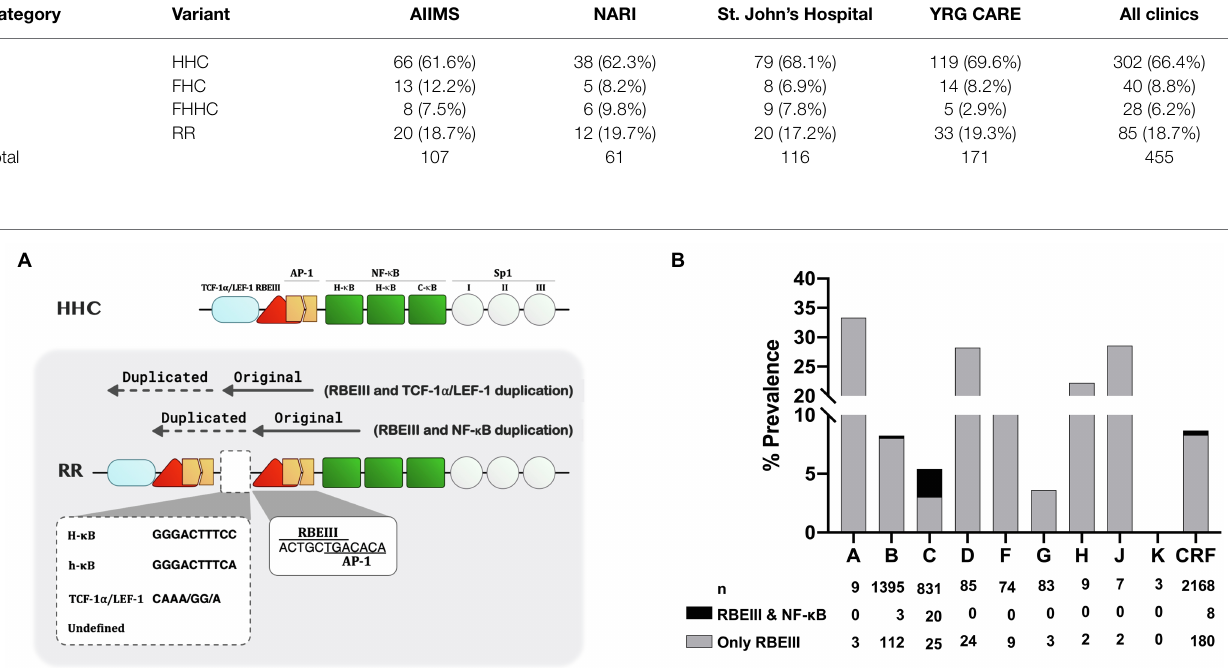
FIGURE 2 | The nature of the RBEIII cluster duplication in HIV-1C. (A) A schematic representation of the RBEIII cluster duplication in the RR group of HIV- 1C variants. The top panel depicts the arrangement of TFBS in the canonical HHC-LTR. The bottom panel portrays the RBEIII cluster duplication (RR, two RBEIII clusters) in two variant LTRs – the co-duplication of RBEIII and TCF-1 α /LEF motifs or RBEIII and NF- κ B motifs. Of note, the RBEIII cluster duplication comprises the copying of a sequence that recruits both RBF-2 and AP-1 (c-Jun and ATF) collectively. The original and duplicated sequences are marked with solid and dotted arrows, respectively. The two RBEIII clusters are typically separated from each other by an intervening sequence that constitutes a binding site for NF- κ B (a canonical H- κ B site or a non-canonical h- κ B site), TCF-1 α /LEF-1 motif, or a sequence of undefined character. (B) The relative prevalence of the RBEIII and/or NF- κ B motif duplication in HIV-1 subtypes. All the available LTR sequences containing the duplication of one or both TFBS were downloaded from the LANL HIV database and categorized under the major HIV-1 subtypes as shown. A single sequence per patient was included in the analysis. The grey and black bars represent the prevalence of duplication of RBEIII and NF- κ B motifs, respectively. n: the number of sequences, CRF: Circulating recombinant